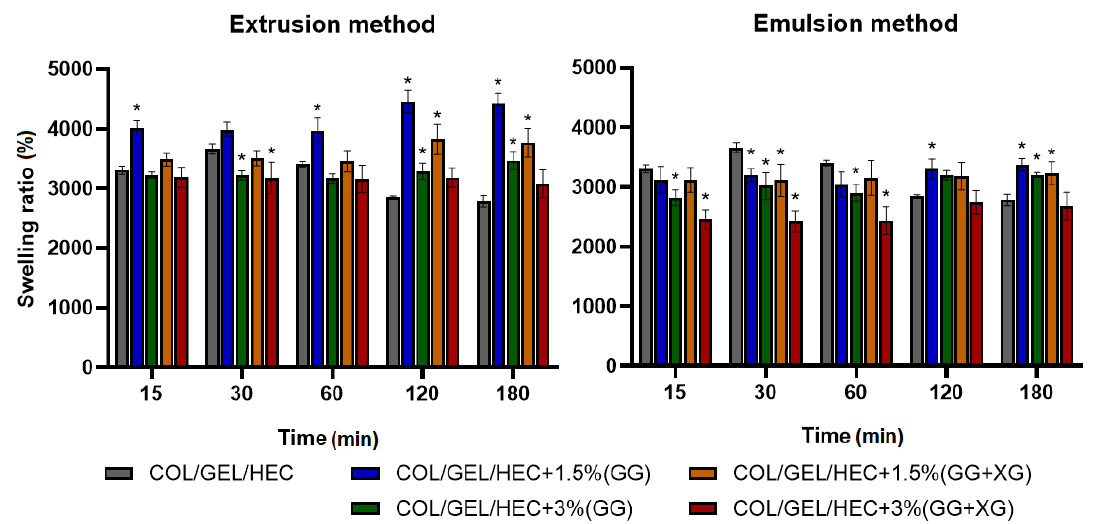
Figure 5. Swelling percentage of COL / GEL / HEC matrices with incorporated microspheres obtained by extrusion and emulsion method. ANOVA-one way with Dunnett’s post-hoc analysis (Cl = 95%) was performed to statistically compare the results. Significant di ff erences compared to the control for each time were marked on the graphs with